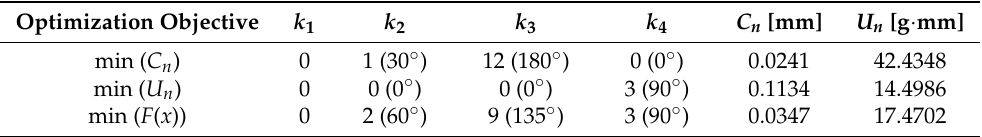
Figure 14. The optimal solution of the single-objective optimization for the unbalance in the 10,000 times simulations. Table 5. The optimal assembly angles of the rotors at each stage and the corresponding coaxiality and unbalance of the high-pressure rotor